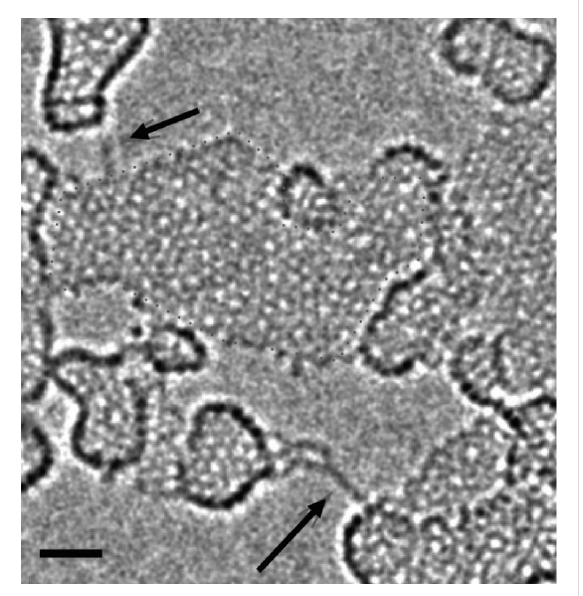
Figure 2: Electron microscopy image of carbon chains (arrowed). The carbon chains span between aggregates on top of a graphene layer (the contrast from the graphene lattice has been removed from the image by Fourier filtering). The scale bar is 1 nm. Courtesy of U. Kaiser, reprinted with permission from [22]. Copyright 2009 IOP publishing & Deutsche Physikalische